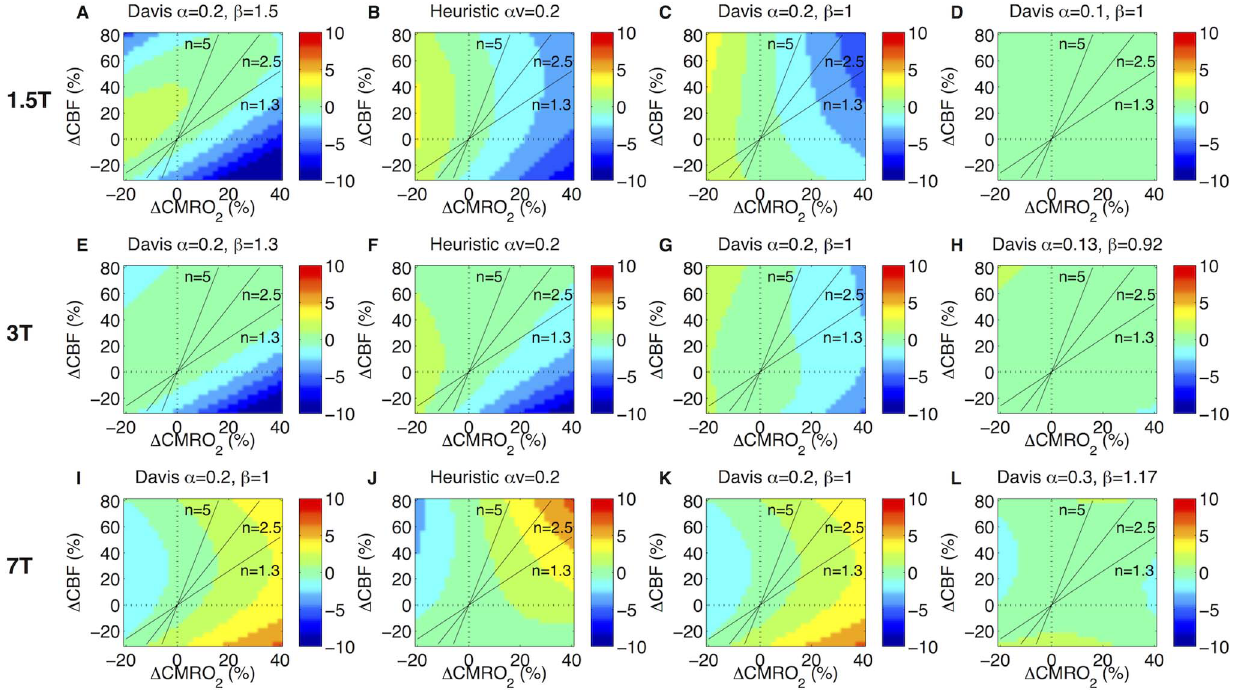
Figure 3. Absolute error in D CMRO 2- calculations. Simulated calibrated BOLD calculations were made for the best guess of physiology and imaging parameters noted in Tables 1 and 2. (A–D) Calculations in the absolute D CMRO 2- error are shown at 1.5T for the 1.5T-adjusted Davis model, the heuristic model, the Davis model with a =0.2 and b =1, and the free parameter Davis model with a and b fitted as noted. Similar calculations are shown for 3T (E–H) and 7T (I–L).